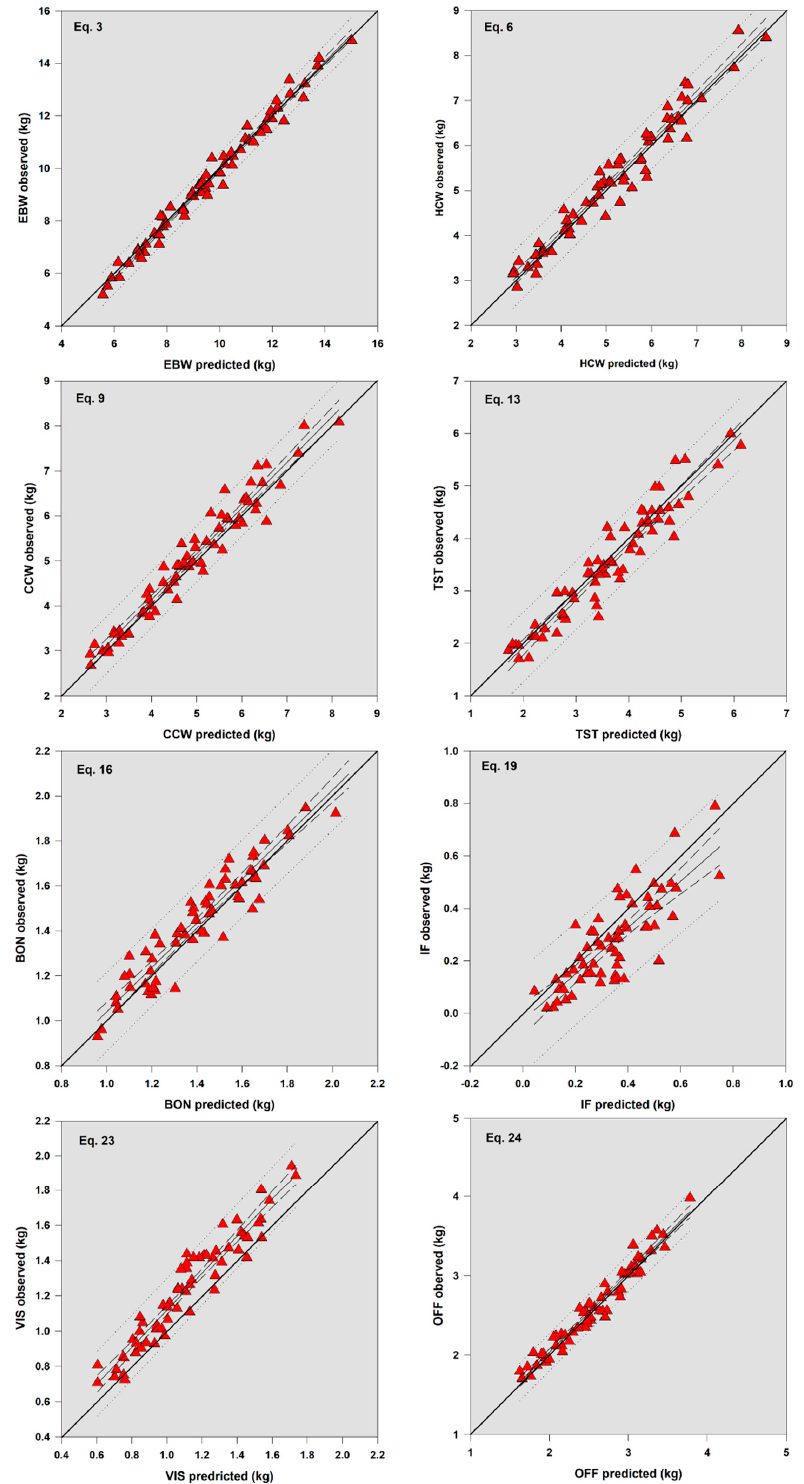
Figure 2. Relationship between observed and predicted values of carcass traits in suckling hair